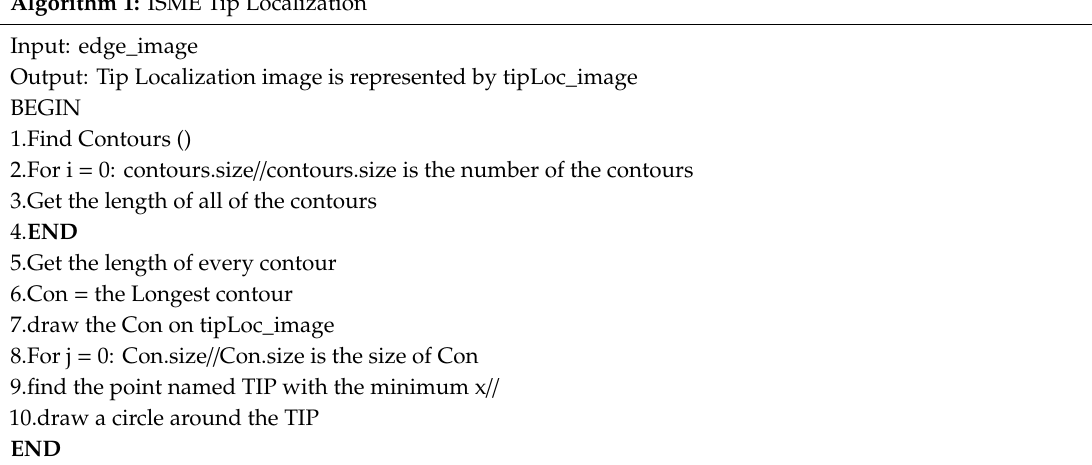
Algorithm 1: ISME Tip Localization